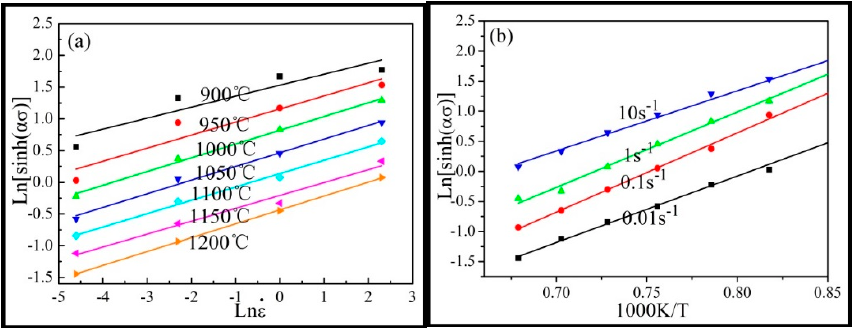
Figure 4. Relationship between peak stress and strain rate. ( a ) Inσ − Inε(cid:4662) ; ( b ) σ − Inε(cid:4662) .